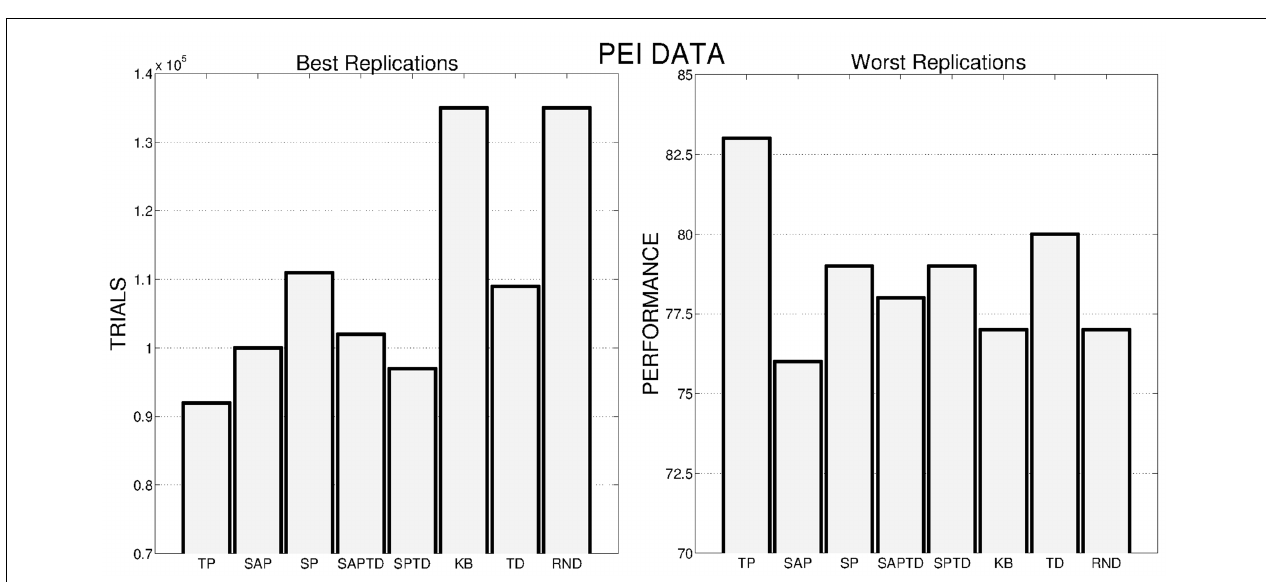
replications per learning rate). If a system has not reached 95% we report above the corresponding bar the average performance at the end of the simulation.